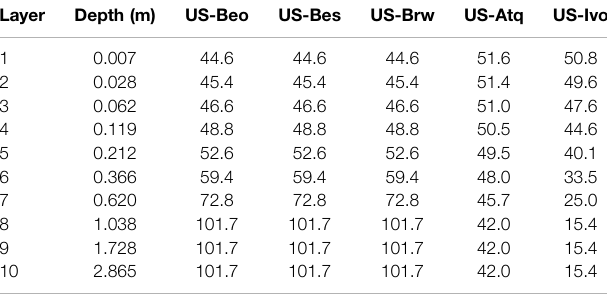
TABLE 1 | Concentration of soil organic carbon (SOC) (kg C m − 3 ) for model initialization for all study sites. Layer Depth (m)